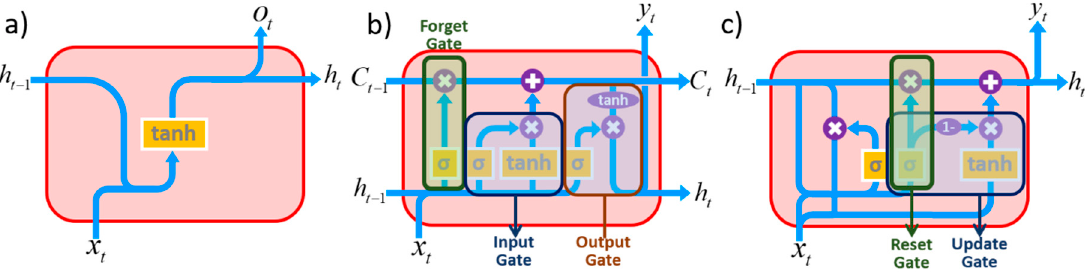
Figure 2. Diagrams of AI models ( a ) recurrent neural network (RNN), ( b ) long short-term memory (LSTM), ( c ) gated recurrent unit (GRU).